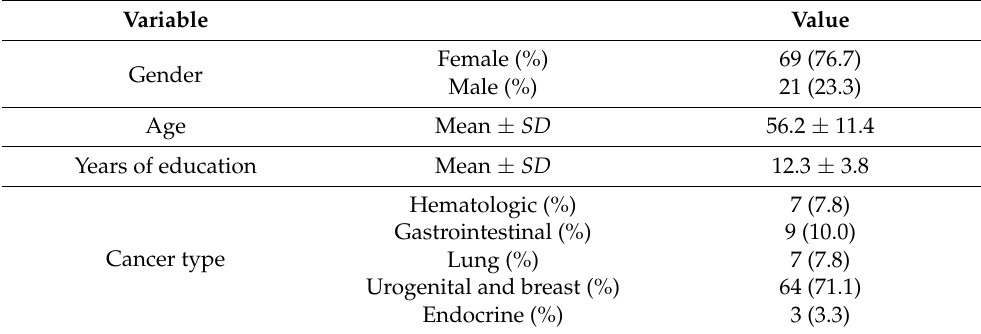
Table 1. Characteristics of the